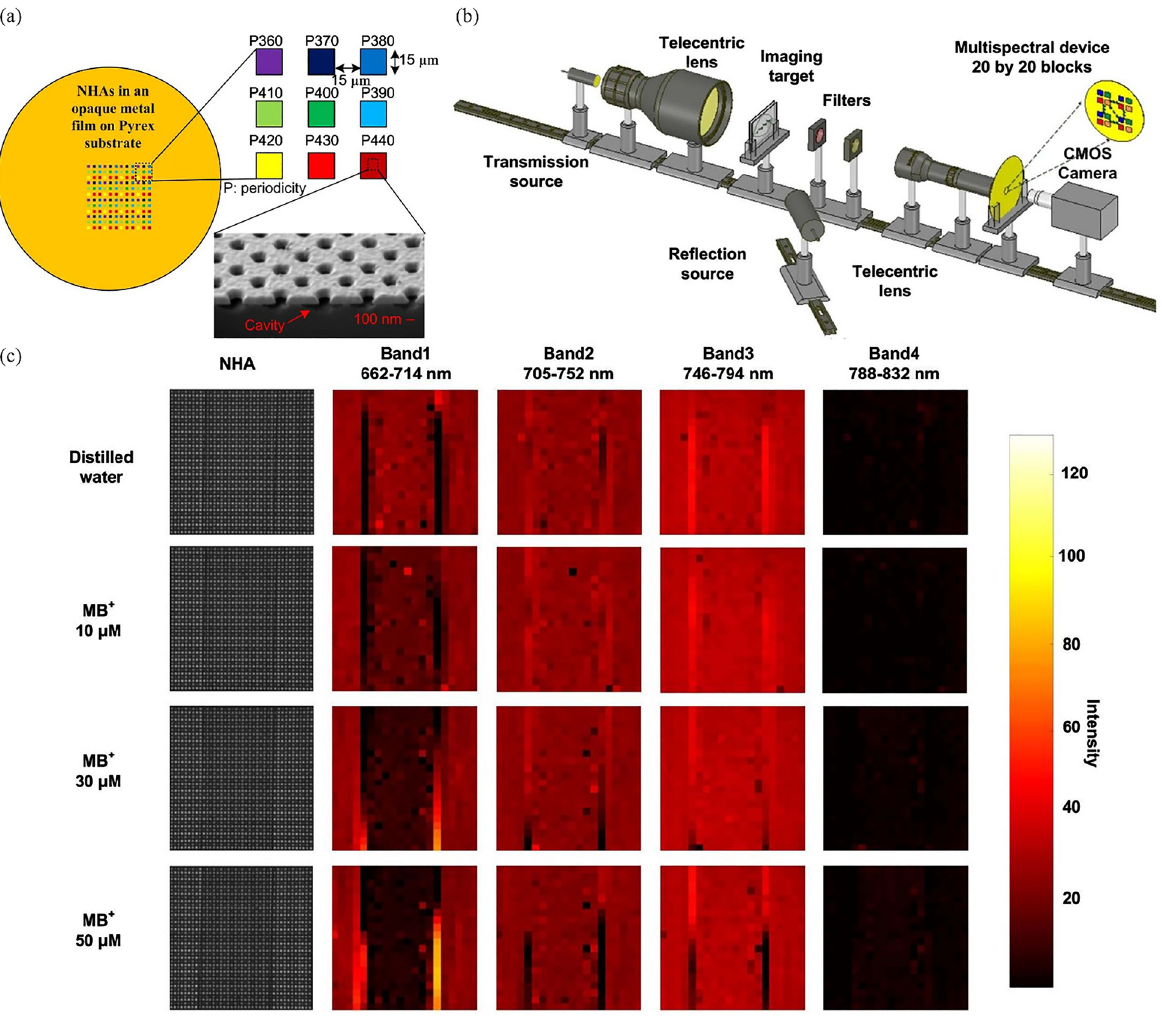
Figure 11: Multispectral imaging using nanohole array. (a) Schematic of mosaic filter formed by nanohole array (NHA). Inset shows the SEM image of the resonance cavity formed by etching through the gold layer. Resonance wavelength variation is achieved by adjusting the NHA period. (b) Multispectral imaging setup working in both transmissionandreflectionmode.NHA-basedmosaicfilterswith20 × 20blocksareimplementedinfrontoftheCMOScamera.(c)Rawimages of NHA and multispectral images of methylene blue (MB + ) under different concentrations (10, 30, and 50 μ M). (a) – (c) are adapted with permission from [75]. Licensed under a Creative Commons